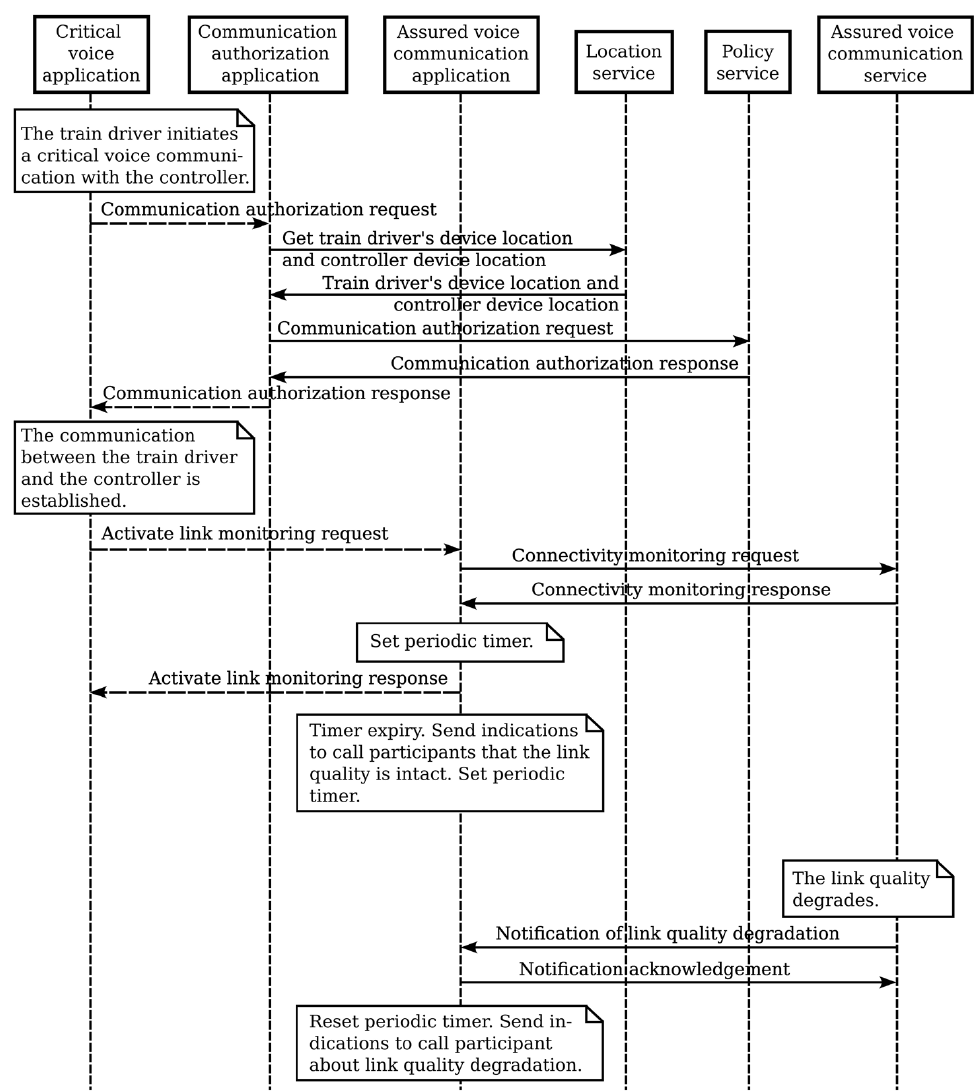
Figure 12. Services interaction flow for communication authorization.